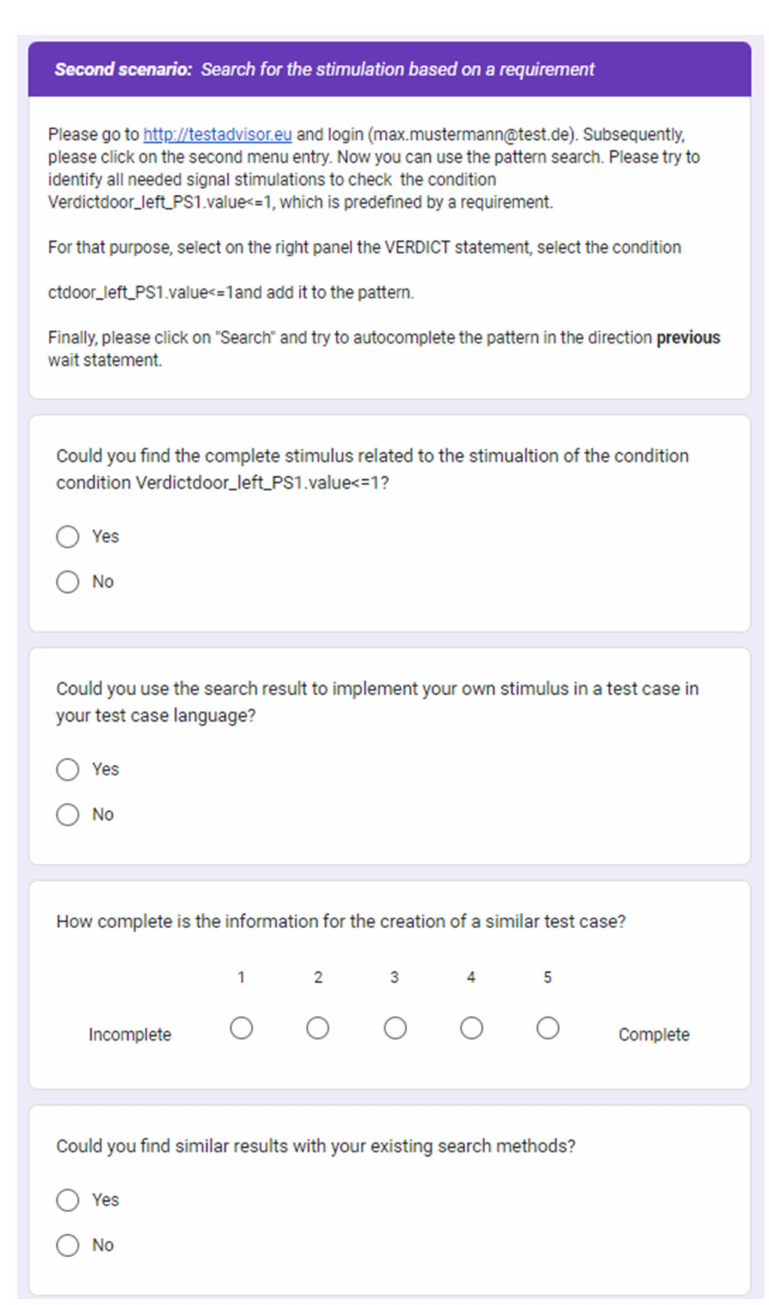
Figure 20. Page two from the